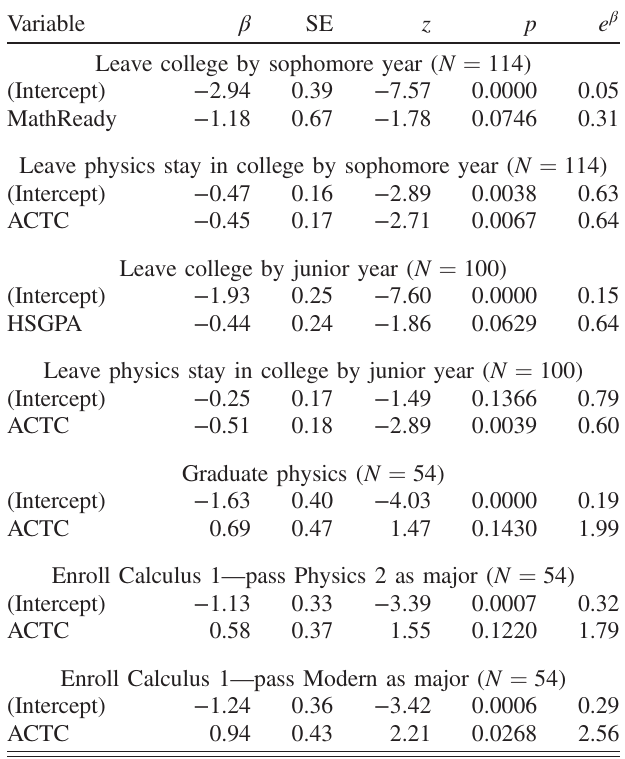
TABLE V. Institution 2: Logistic regression. All regressions are significant improvements over the null model ( p < 0 . 001 ). β is the normalized regression coefficient, SE is its standard error, z is the z score of the coefficient, p the probability a value larger than z occurred by chance, and e β is the odds